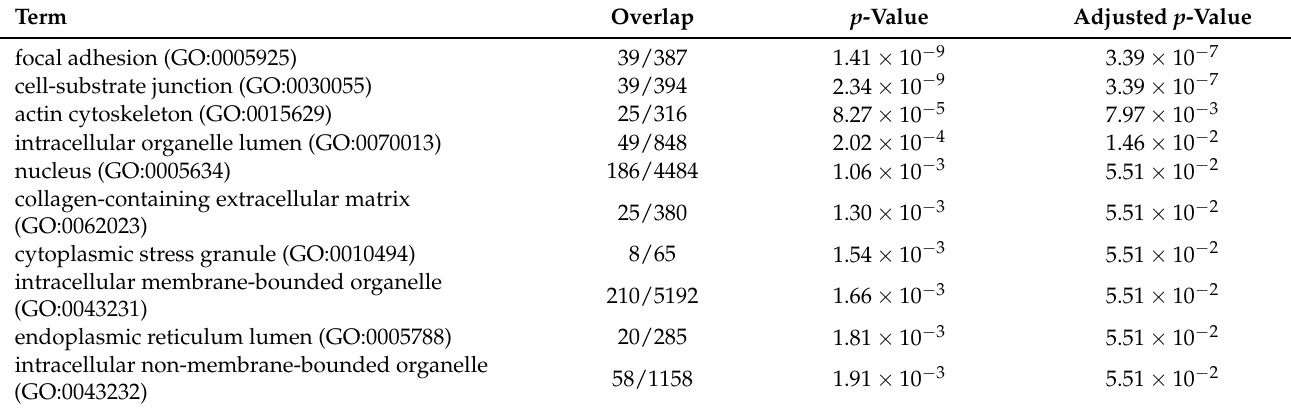
Table 8. The top 10 enriched terms in “GO Cellular Component 2021” using Enrichr. Overlap is the number of common genes between the genes uploaded and the genes in the category divided by the number of genes in the category. Probes, whose associated genes were uploaded to Enrichr, were identified using linear regression.